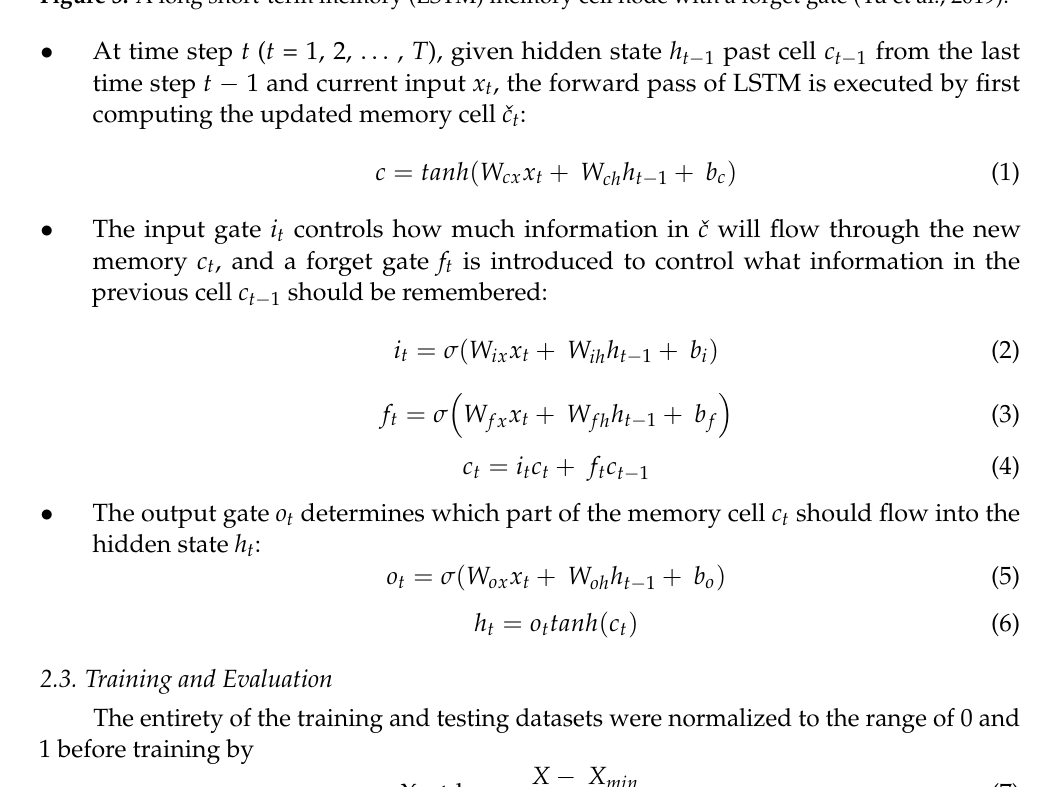
Figure 3. A long short-term memory (LSTM) memory cell node with a forget gate (Yu et al., 2019).